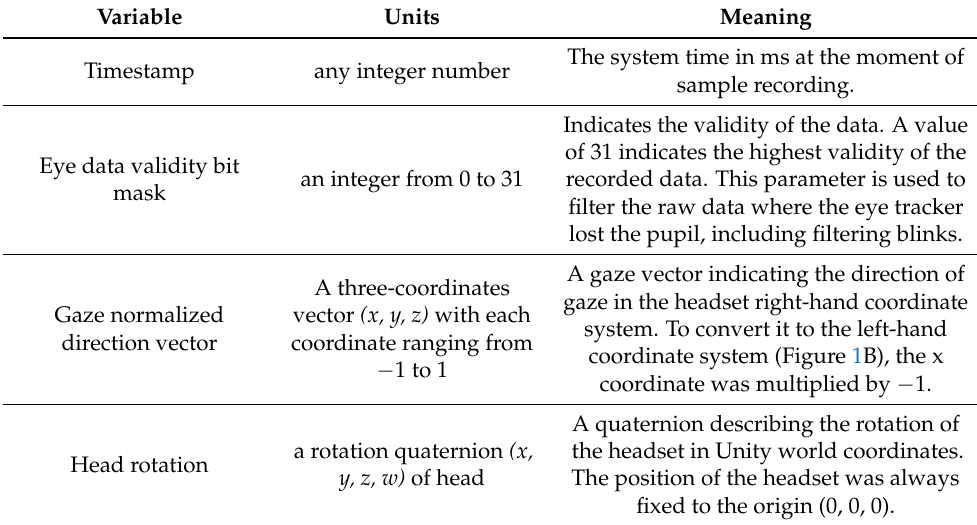
Table 1. Main eye- and head-movement-related raw variables recorded during the experiment.